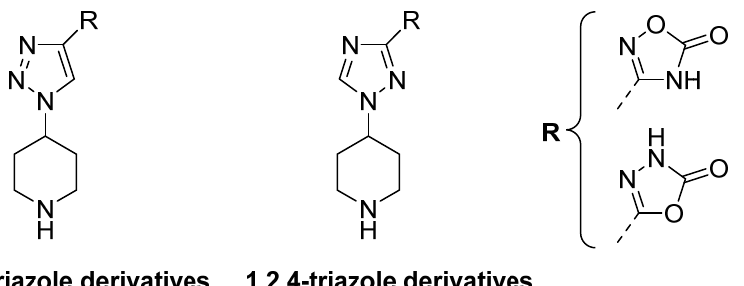
Figure 2. General structure for the hypothesized components, which include a piperidine ring, a triazole ring, and an oxadiazolone ring.